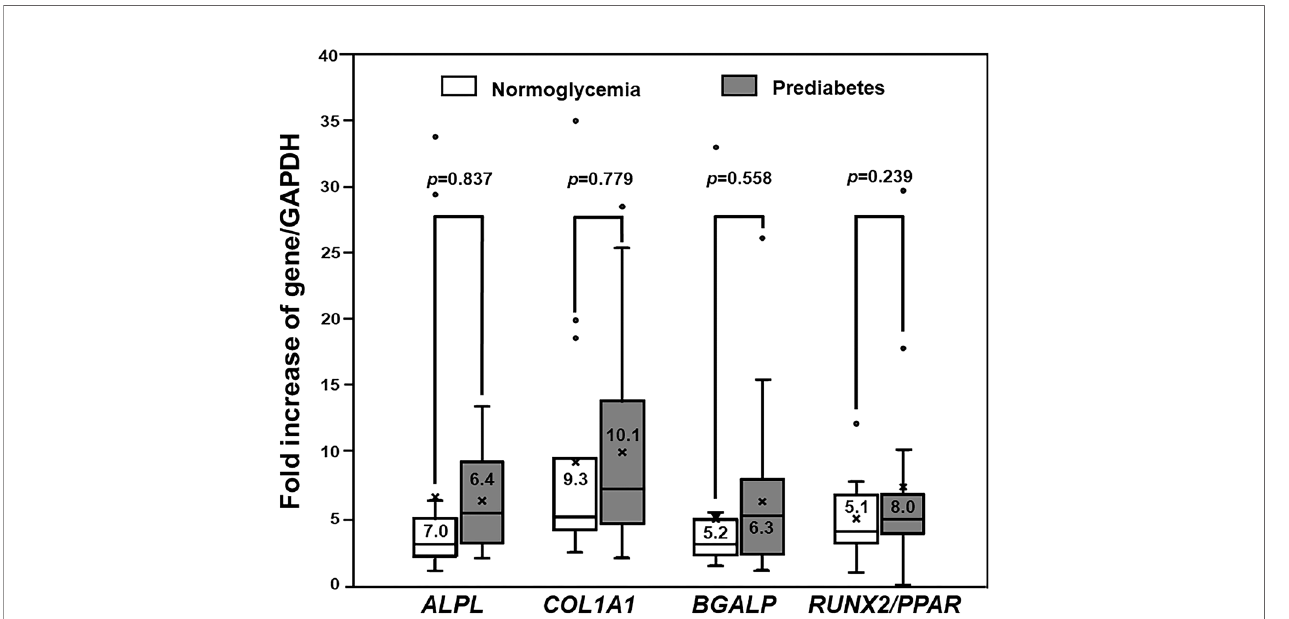
FIGURE 1 | The Expression of Osteogenic Differentiation Markers. Box and whisker plots to show a comparison of the expression of osteoblast-speci fi c genes between participants with normoglycemia and patients with prediabetes (mean ± SD). Both prediabetic and normoglycemic groups had comparable levels of osteoblast-speci fi c gene expression, namely, ALPL , COL1A1 , BGALP , and RUNX2/PPAR g ratio ( RUNX2/PPAR